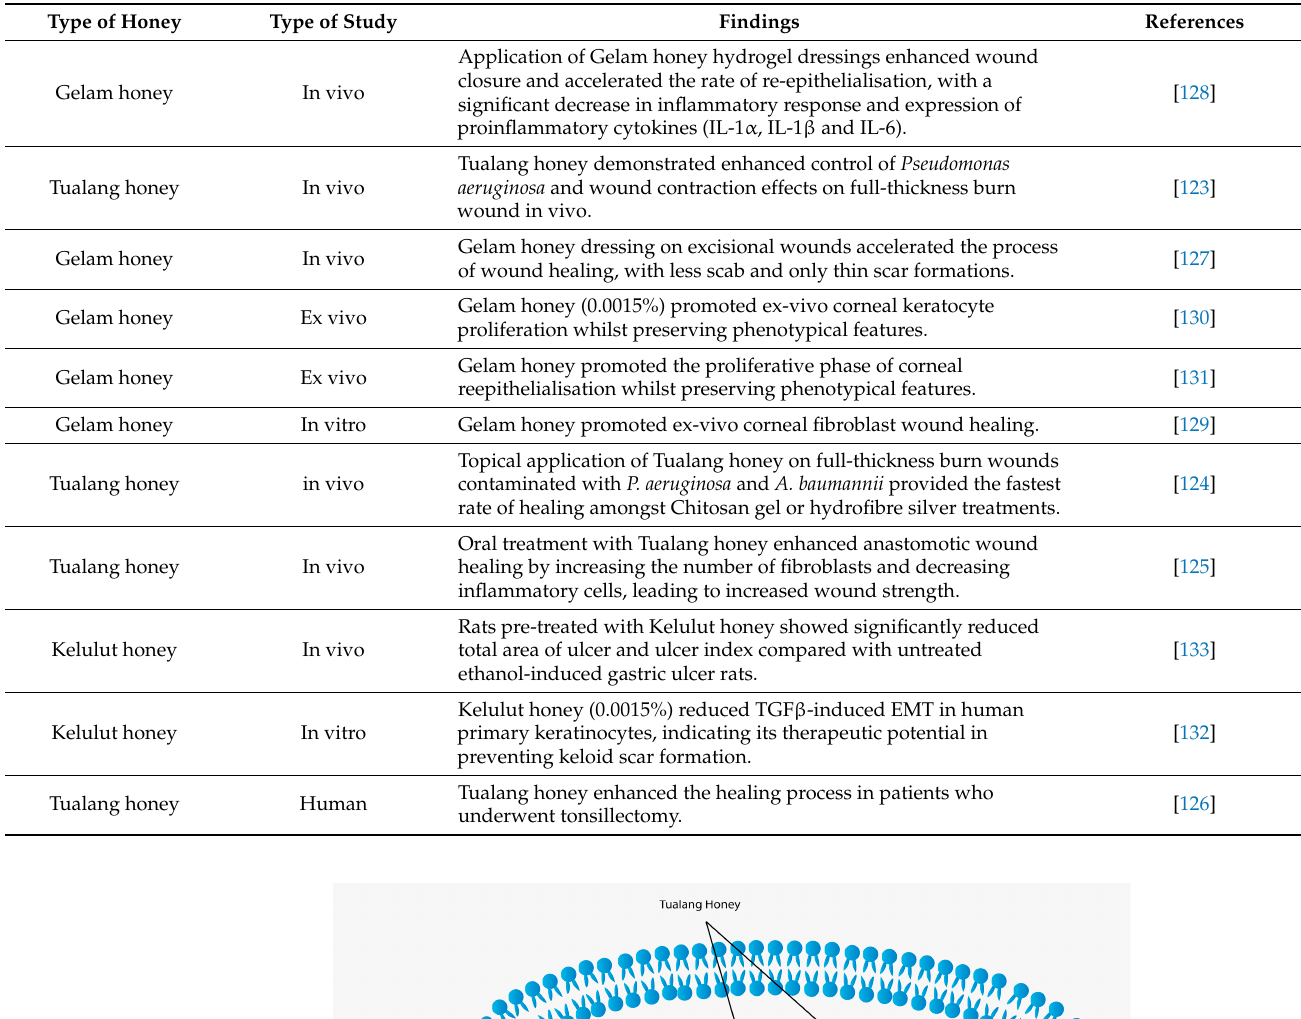
Table 9. Summary of wound-healing properties.